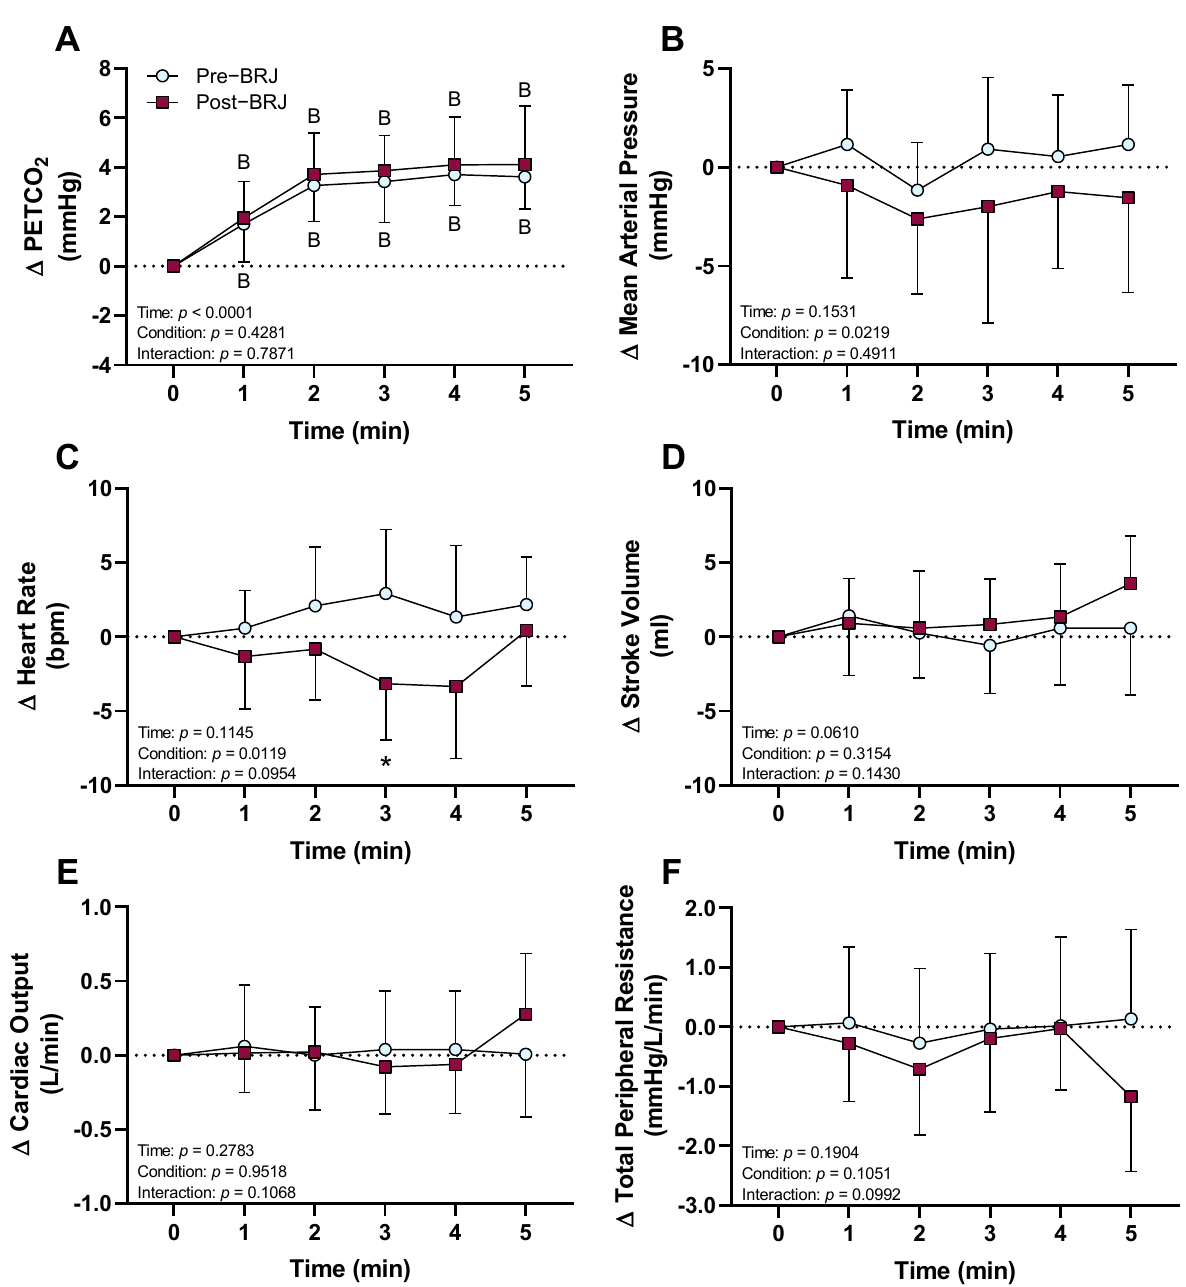
Figure 2. Effect of beetroot juice (BRJ, condition) at three hours post-consumption on the hemodynamic response to five minutes of CO 2 breathing (time). Data are presented as the means ± SD as the change from room air baseline (0 min). Data were analyzed using a two-way repeated-measures ANOVA with post hoc Dunnett’s tests to compare changes during CO 2 from room air baseline and post hoc Sidak’s tests to compare differences between pre-and post-beetroot juice consumption during CO 2 breathing. ( A ) PETCO 2 : partial pressure of end-tidal CO 2 ; ( B ) mean arterial pressure; ( C ) heart rate; ( D ) stroke volume; ( E ) cardiac output ( F ) total peripheral resistance. n = 14 (7 females and 7 males). B different from room air baseline ( p ≤ 0.0074); * different from pre-beetroot juice consumption ( p = 0.0539).